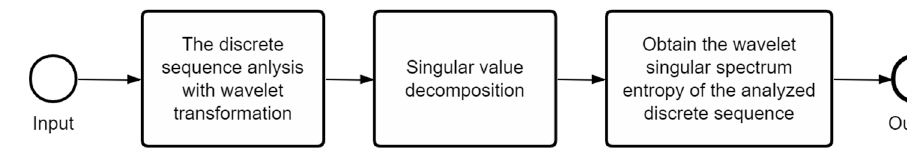
Figure 1. Flow chart of the WSE calculation.